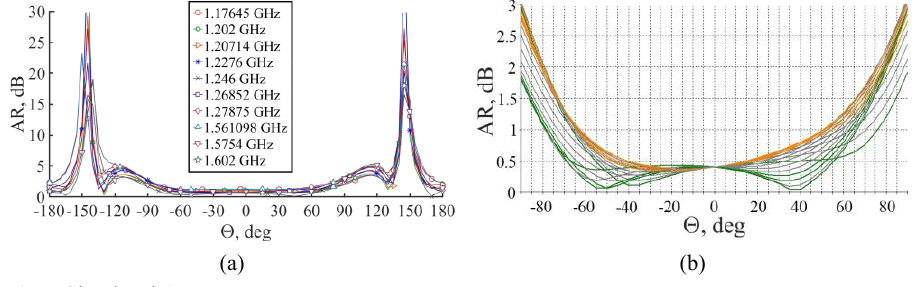
Fig. 5 Simulated AR patterns.